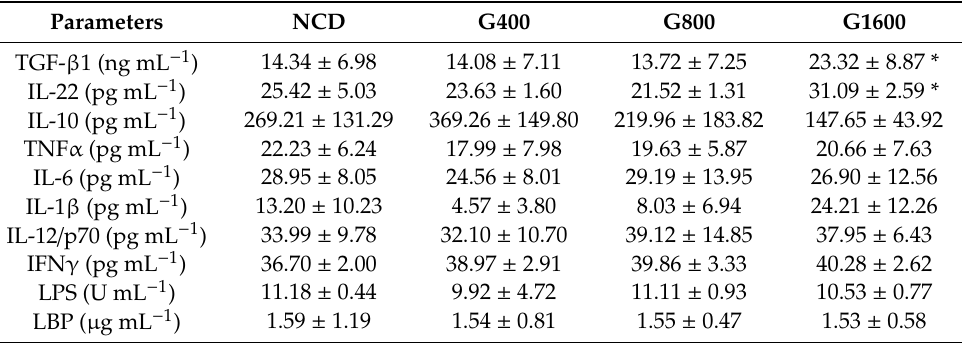
Table 2. E ff ect of GML on the serum anti-inflammatory and pro-inflammatory factors.